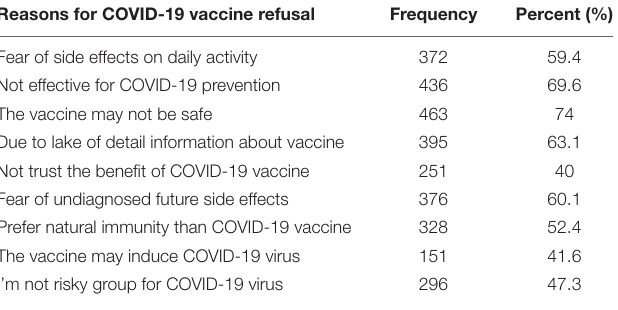
TABLE 2 | Reasons for refusal of accepting the COVID-19 vaccine among college students in Gondar city, Northwest Ethiopia, 2021 ( n = 412). Reasons for COVID-19 vaccine